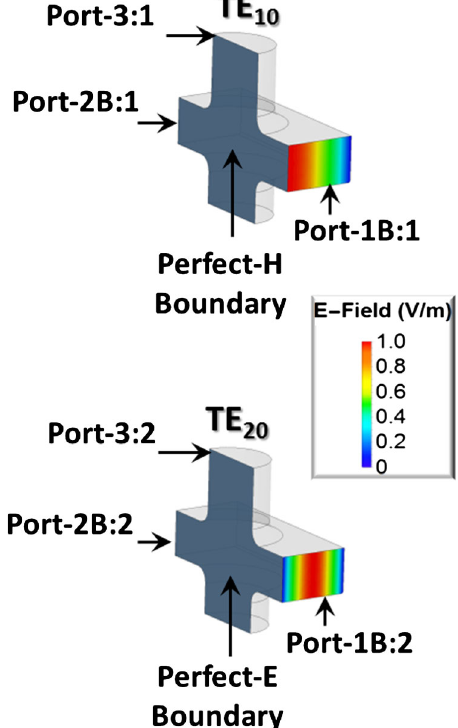
FIG. 4. A cross section view of network-B with the boundary conditions used to isolate the even mode (top) and odd mode (bottom) for this